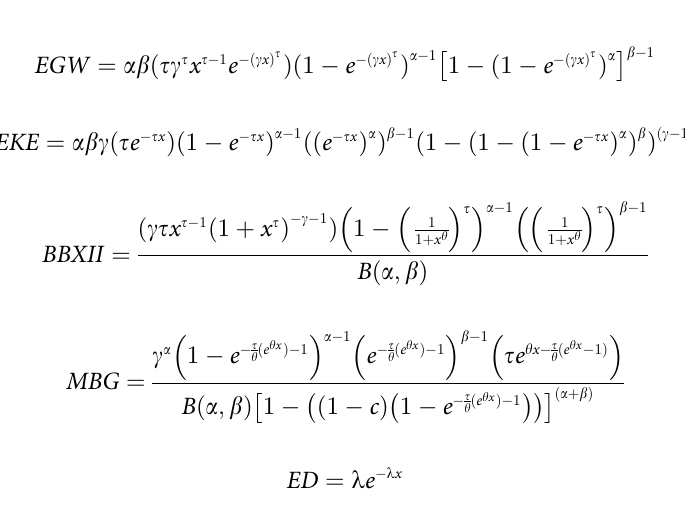
5.9.1 Survival times of breast cancer patients. The real data set represent the survival times of 121 patients with breast cancer obtained from a large hospital in a period from 1929 to 1938 [23]. The data are: 0.3, 0.3, 4.0, 5.0, 5.6, 6.2, 6.3, 6.6, 6.8, 7.4, 7.5, 8.4, 8.4, 10.3, 11.0, 11.8,